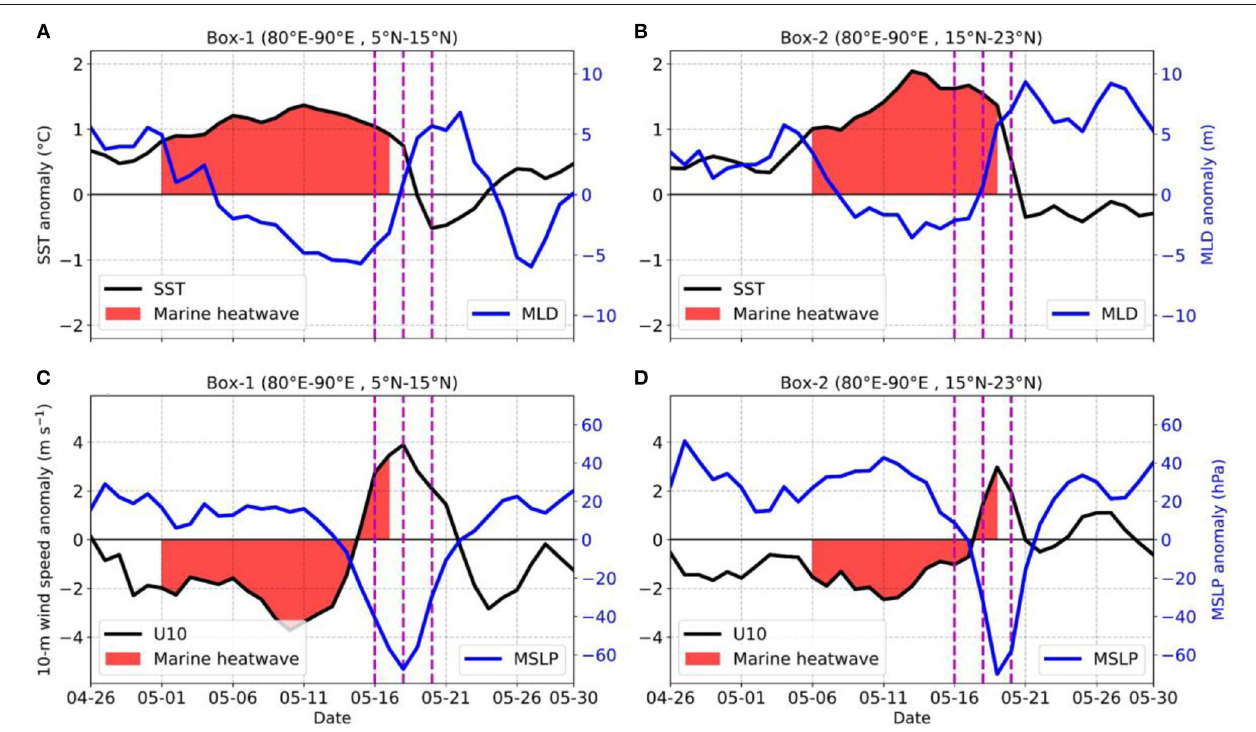
FIGURE 2 | Time series of the sea surface temperature anomaly (black, ◦ C) and mixed layer depth anomaly (blue, m) for (A) box 1, (B) box 2. Time series of 10m surface wind anomaly (black, m s − 1 ) and mean sea-level pressure anomaly (blue, hPa) for (C) box 1 (D) box 2 for the duration of 26-April-2020 to 30-May-2020 with the red shading representing marine heatwave conditions and the vertical magenta lines representing cyclogenesis (left, 16-May-2020), cyclone intensification (middle, 18-May-2020) and landfall (right, 20-May-2020) for the tropical cyclone